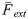
Mechanical model of the foot as applied in inverse dynamics.The external force F¯ext, its point of application r¯1 and the markers s¯1 and s¯2 are input of the analysis. Torques of F¯ext, the net ankle force F¯1 around the foot’s center of mass, the net ankle torque T1 and the force of gravity m1g are inserted into Newton’s equations of motion and solved for F¯1 and T1. These are subsequently reversed according to Newton’s third law and input for the same procedure on the shank.